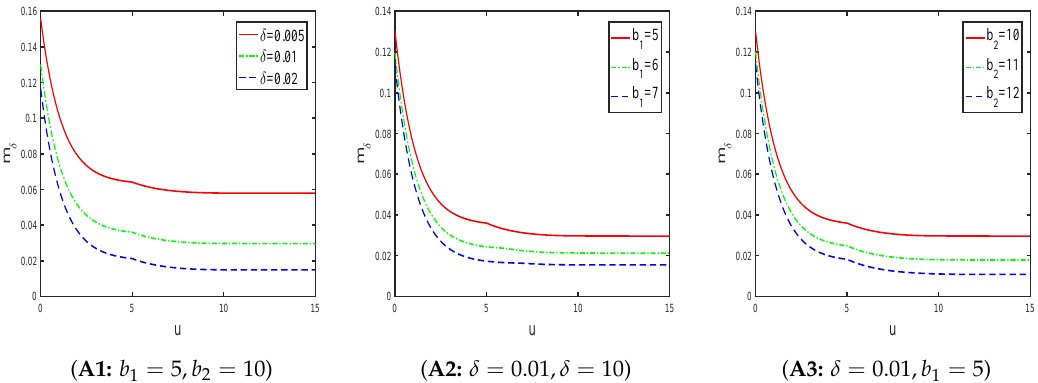
Figure 2. The Laplace transformation of the ruin